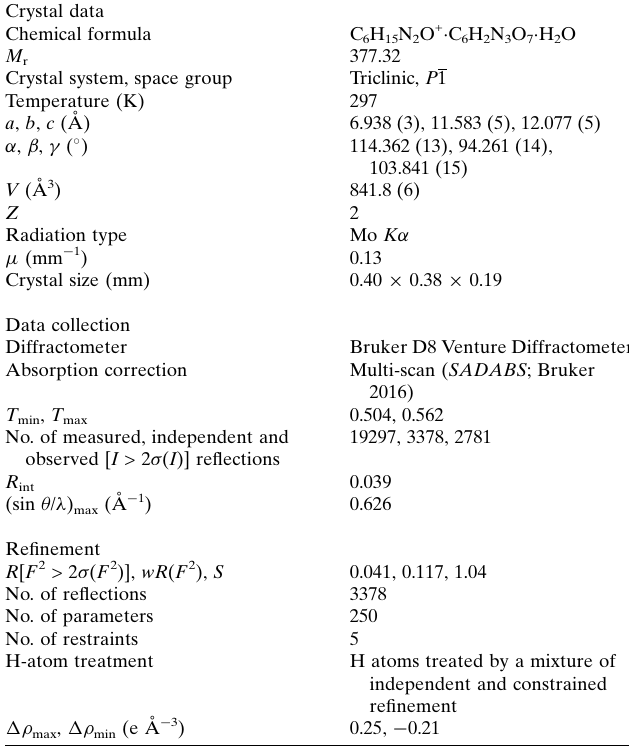
Table 2 Experimental details. Crystal data Chemical